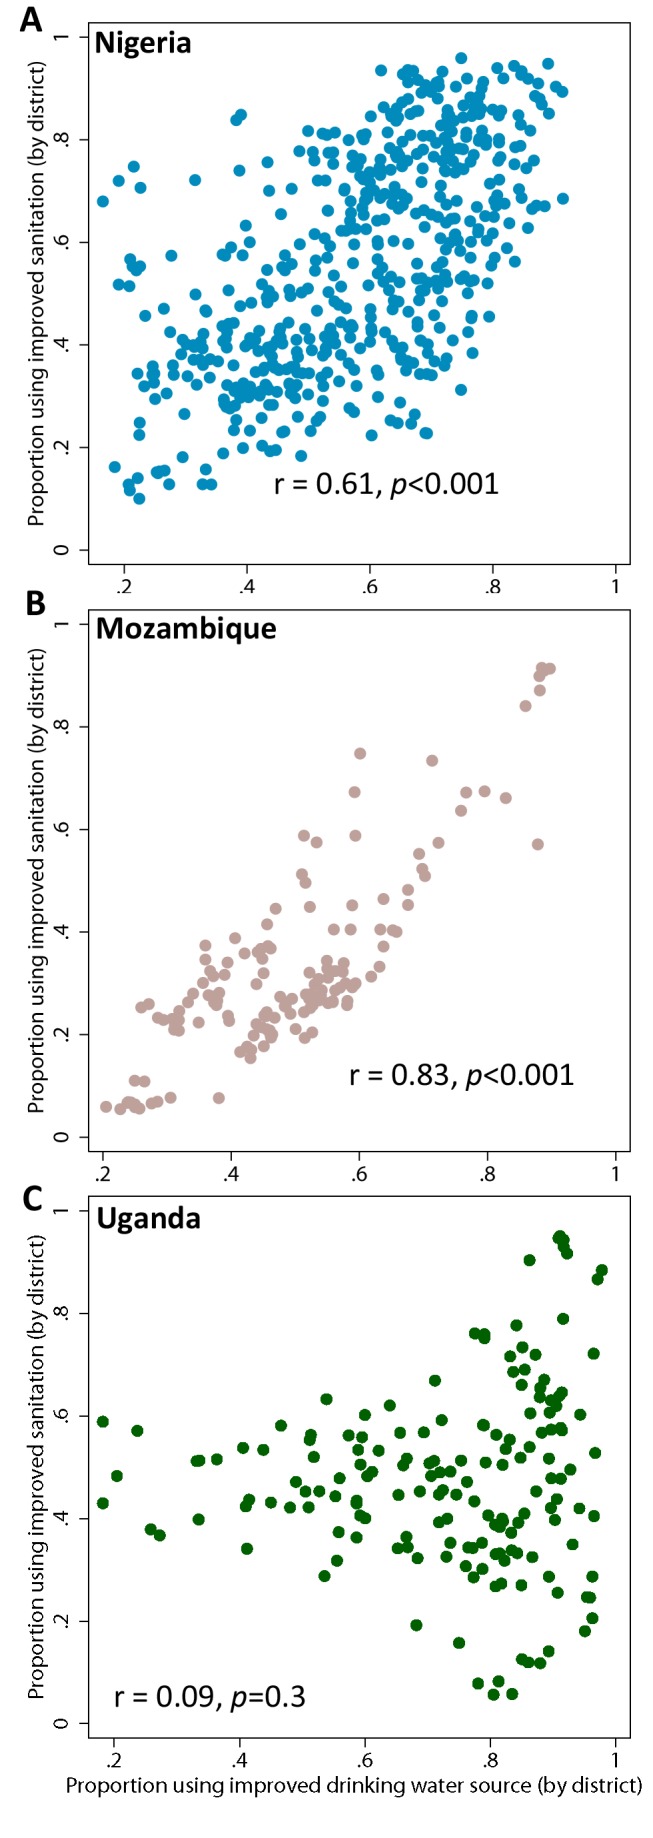
Comparison of coverage in improved drinking water against improved sanitation in overall population, by second administrative area.Comparisons are made for (A) Nigeria, (B) Mozambique and (C) Uganda. r is the Pearson pairwise correlation coefficient. Each dot represents one administrative area.